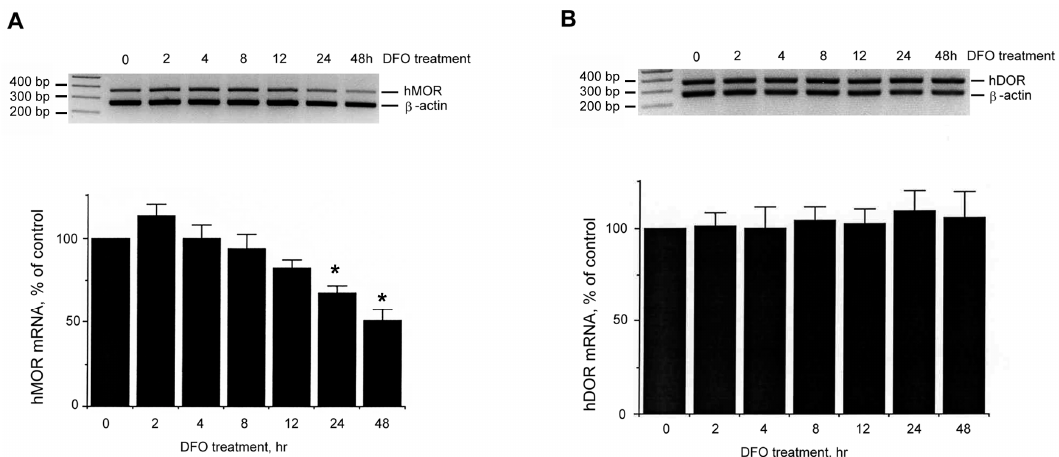
Figure 7. Effect of DFO on hMOR and hDOR gene expression at various time points. Cells were treated without (control; indicated as “0”) or with DFO for various time points (2 to 48 h). RNAs from surviving/attached cells were extracted. Semi-quantitative RT-PCR was performed using hMOR ( A ); or hDOR ( B )-specific primers. Human β -actin specific primers were included as an internal control for normalization. The normalized message from the non-DFO treated control was arbitrarily defined as 100%. Quantitative analysis of message levels is presented as mean ± S.E.M. Experiments were repeated at least six times. “*” indicates p < 0.01. (Student t -test).